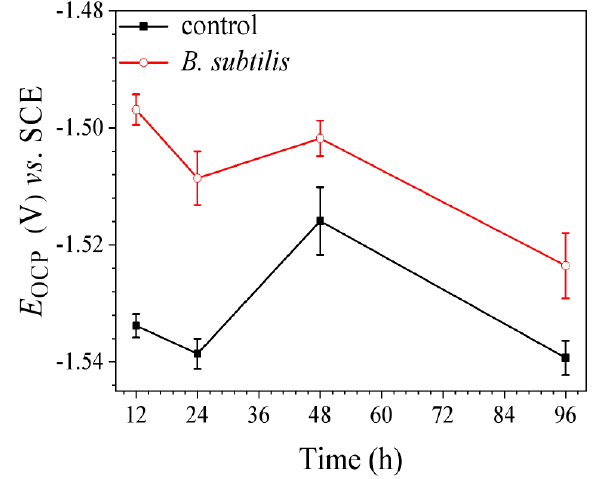
Figure 2. The changes of E ocp with immersion time of AZ31B magnesium alloy specimens in control group and B. subtilis presence group. Scatter bands represent the standard deviations of the three tests.